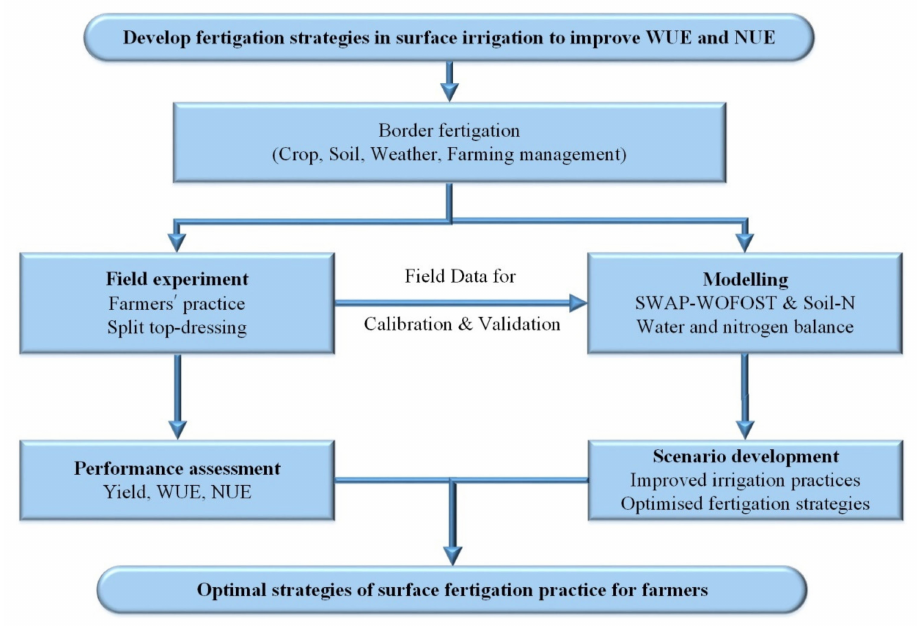
Figure 1. Flowchart of the research